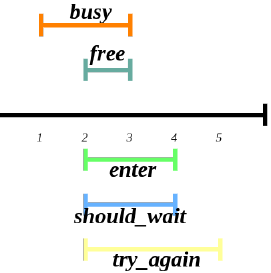
Figure 3. Time constraints for the AV_agent automaton synchronized